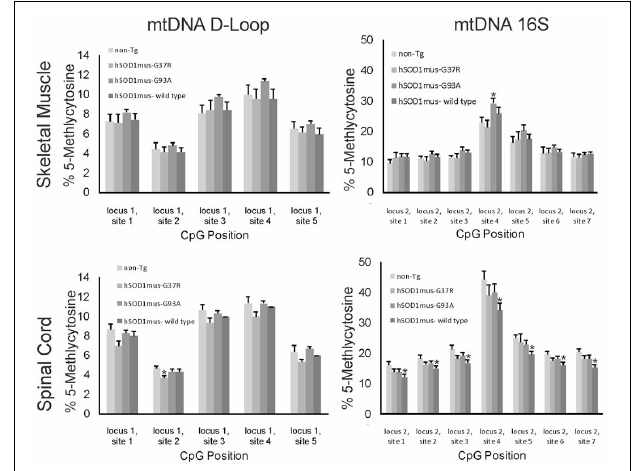
FIGURE 7 | 5-methylcytosine (5mC) content in two loci of skeletal muscle mtDNA in non-conditional transgenic mouse models of ALS. Graphs show the %5mC content at 5 CpG sites in the D-loop ( left ) and at 7CpG sites in the 16S rRNA gene in the skeletal muscle ( top ) and spinal cord ( bottom ) of tg mice with expression of G37R or wildtype hSOD1 variants. Tg and non-tg control mice were 8–10 months of age. Values are mean ± SEM derived from mtDNA isolated from three different mice per genotype. Asterisks denote significant increase in hSOD1-G37R mice compared to non-tg control ( p < 0 . 05).